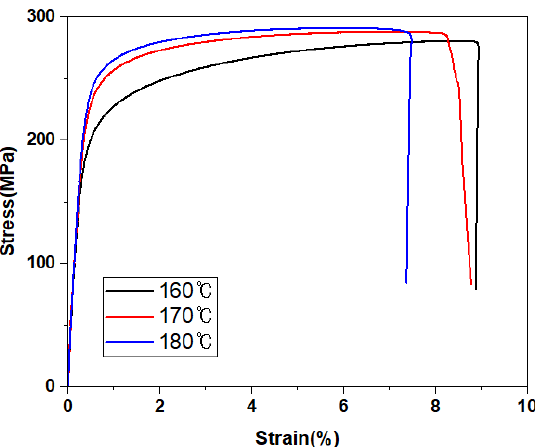
Figure 9. Stress–strain curves of the alloys after the solid solution heat treatment at 520 °C for 90 min, followed by aging heat treatment for 180 min at ( a ) 160 °C, ( b ) 170 °C, and ( c ) 180 °C . Table 6. Tensile properties of the alloy after the solid solution heat treatment and aging heat treatment. Solution